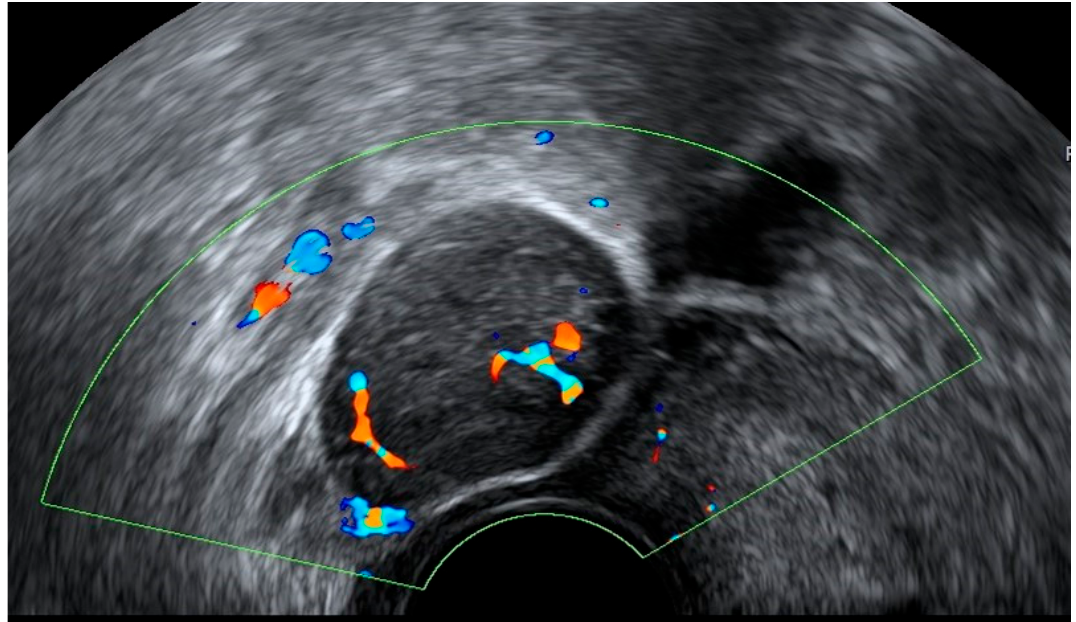
Figure 27. Color Doppler transvaginal ultrasound shows in the right adnexal region, a well-defined solid mass with cystic areas and scattered vessels in a patient with histological result of neurofi-